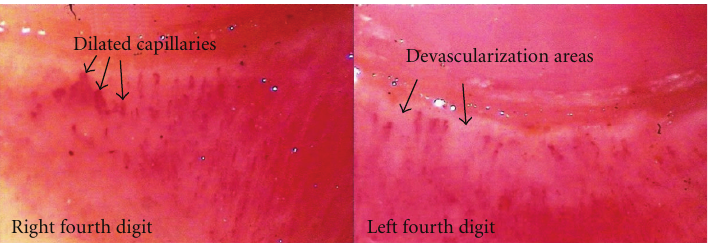
Figure 2: Panoramic nailfold capillaroscopy of the left and right fourth digits showing a scleroderma standard microangiopathy: dilated capillaries and devascularization